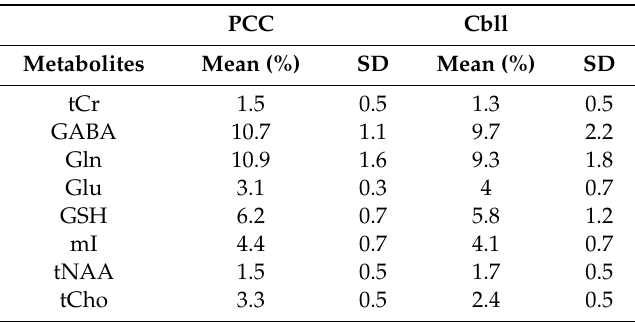
Table 1. Cram é r–Rao lower bound (CRLB) in PCC and Cbll.